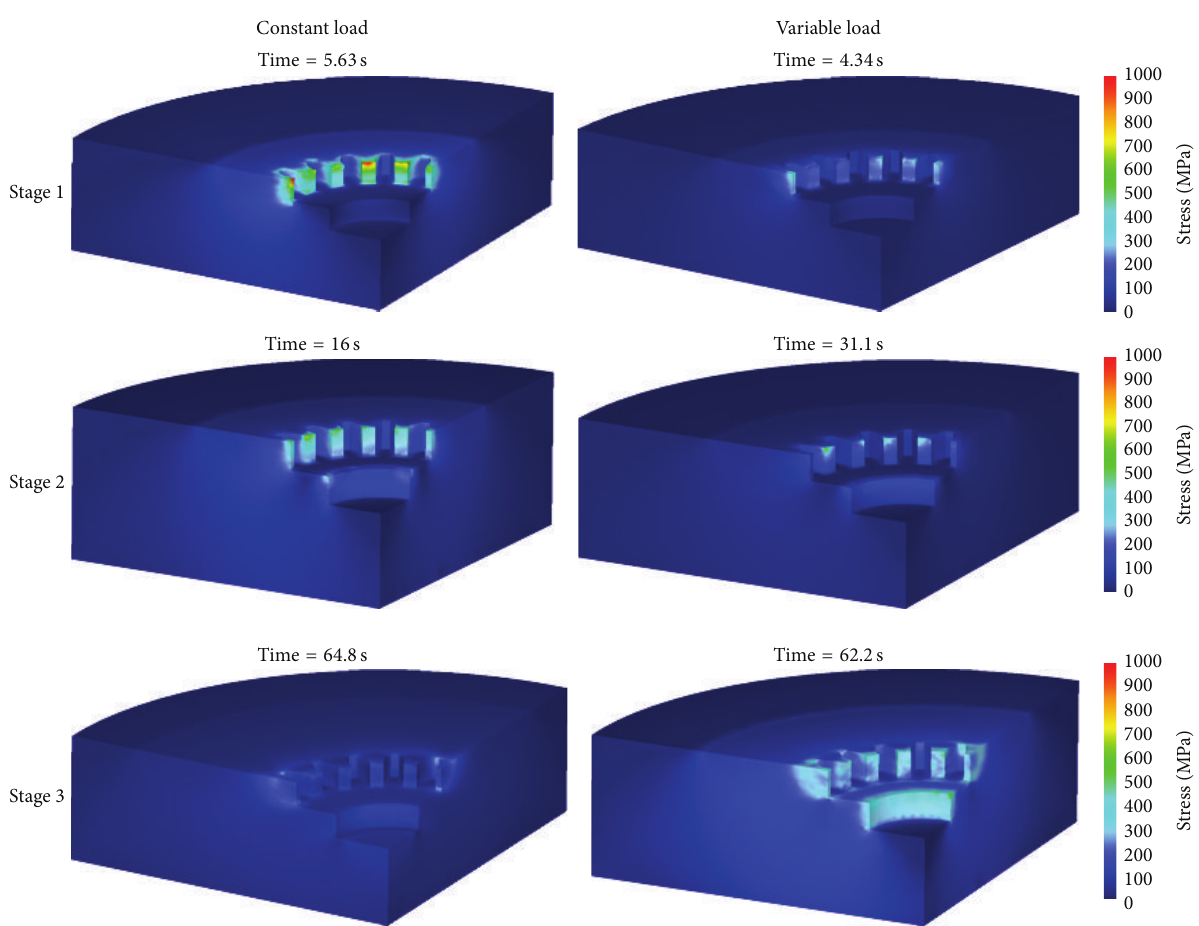
Figure 5: The stress distribution in silicon mold for the two load